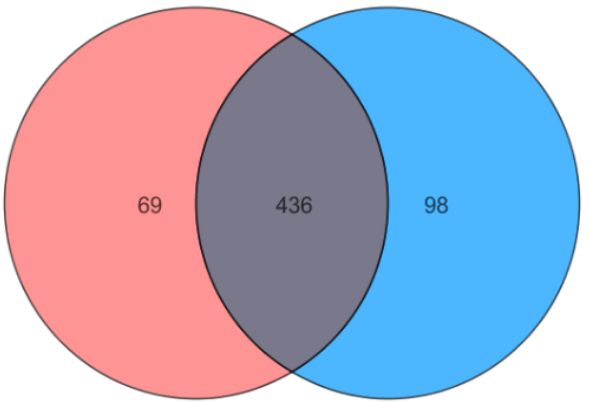
Figure 2. Venn diagram of MDA-MB-231 (red) and MCF-7 (blue) compounds. Both cell lines share 436 compounds (gray); 69 and 98 are found only in MDA-MB-231 and MCF-7, respectively.